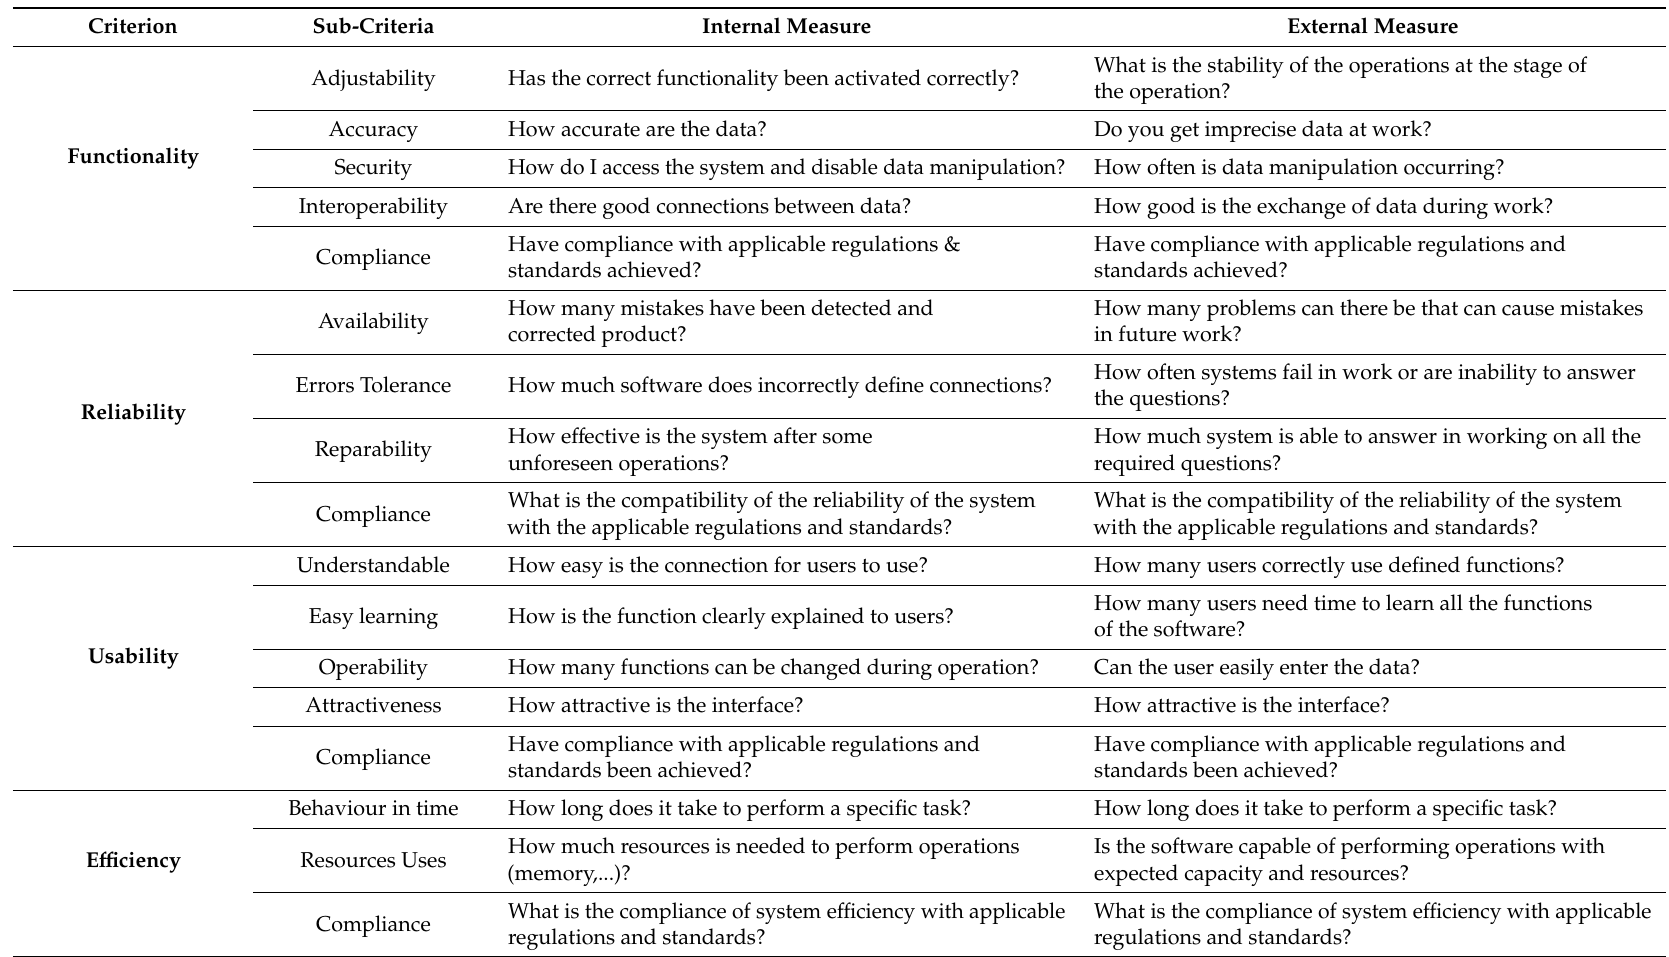
Table 2. Internal and external measures in relation to the 6 evaluating